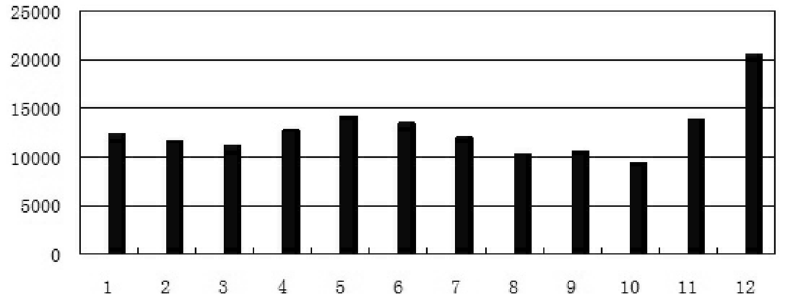
Figure 1. The numbers of outpatients with RTIs in months of the year